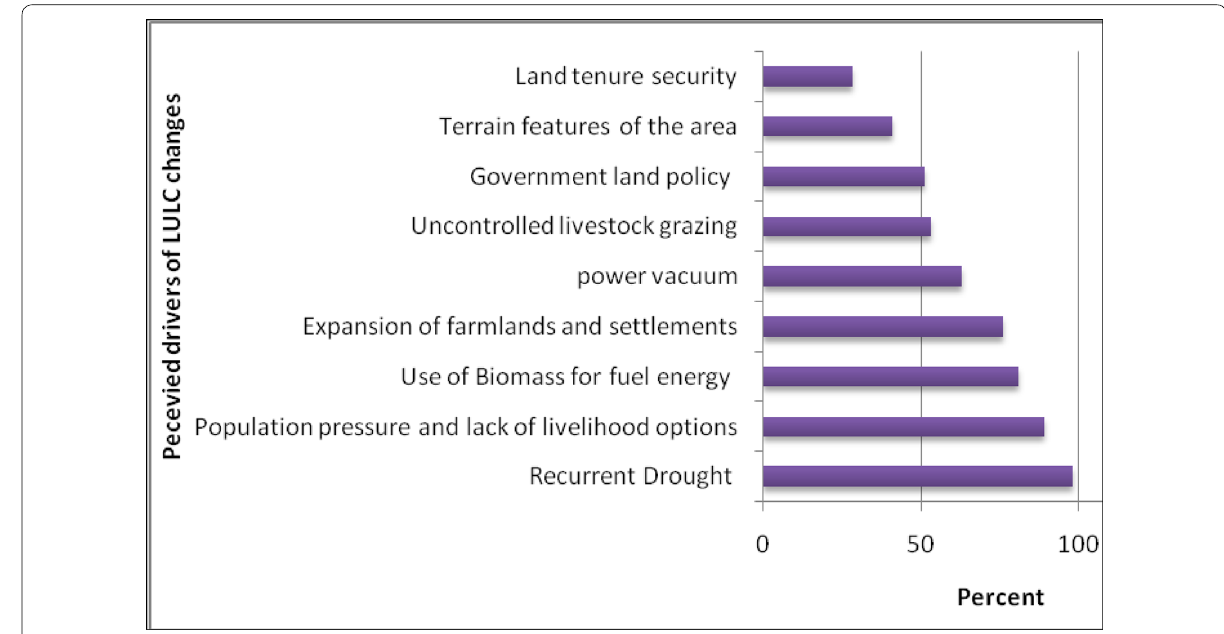
Fig. 10 Drivers of LULC change ranking by the local communities